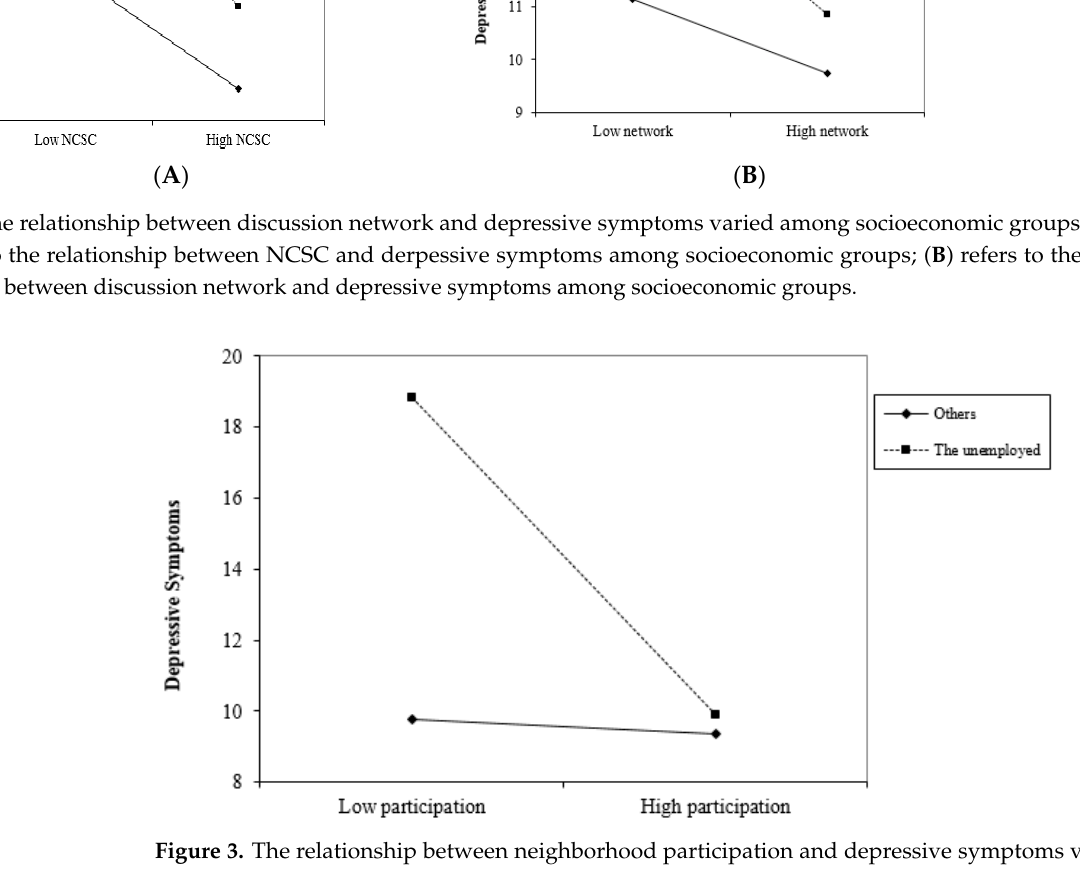
Figure 2. The relationship between discussion network and depressive symptoms varied among socioeconomic groups. ( A ) refers to the relationship between NCSC and derpessive symptoms among socioeconomic groups; ( B ) refers to the relationship between discussion network and depressive symptoms among socioeconomic groups.